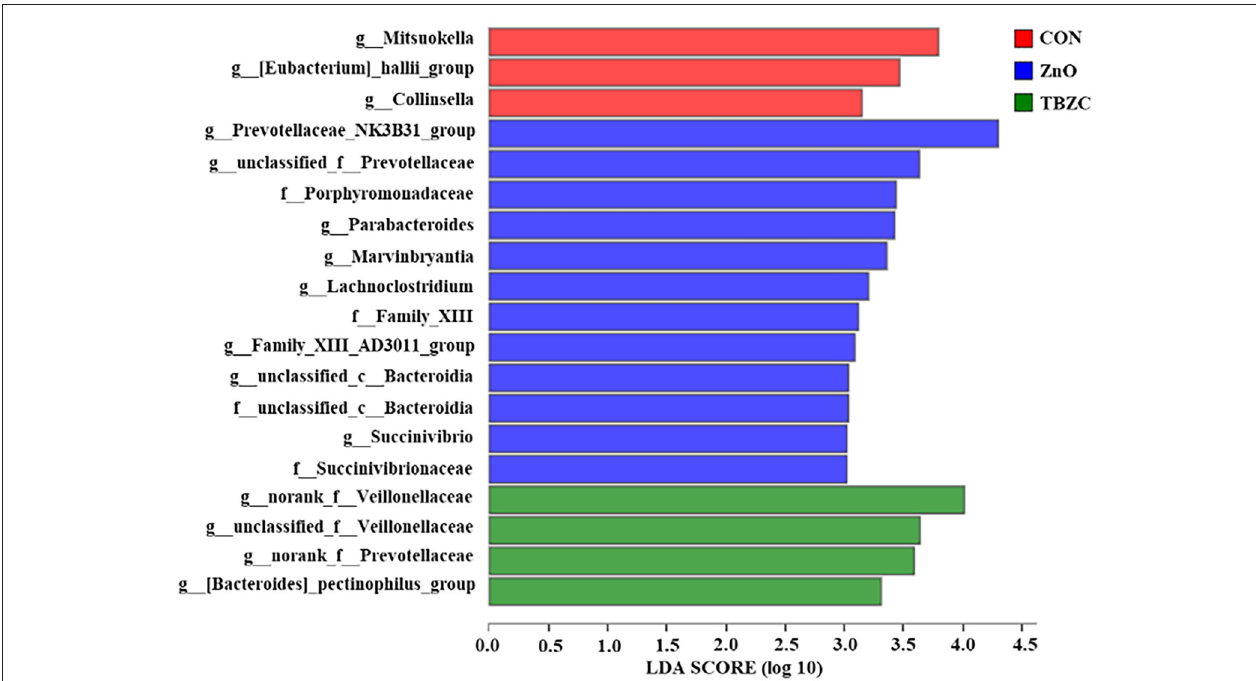
FIGURE 3 | Linear discriminant analysis effect size (LEfSe) analysis of the fecal microbiota of weaned piglets ( n = 6). The linear discriminant analysis (LDA) score chart is shown for species with an LDA score > 2. Red, blue, and green squares represent the CON, ZnO, and TBZC groups, respectively. CON, a basal diet without any Zn source addition; ZnO, CON + 1,600mg Zn/kg from zinc oxide; TBZC, CON + 1,000mg Zn/kg from tetrabasic zinc